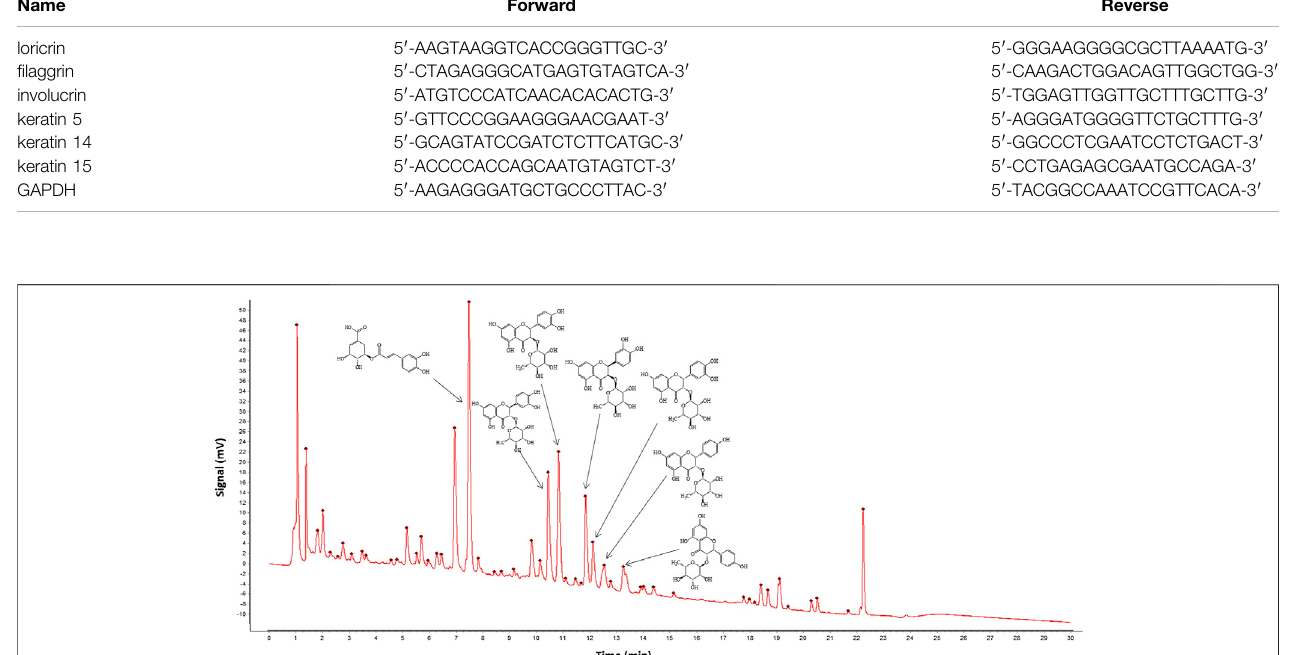
FIGURE 1 | Chromatogram fi ngerprint was performed for quality control of seven herbs in FZHFZY.